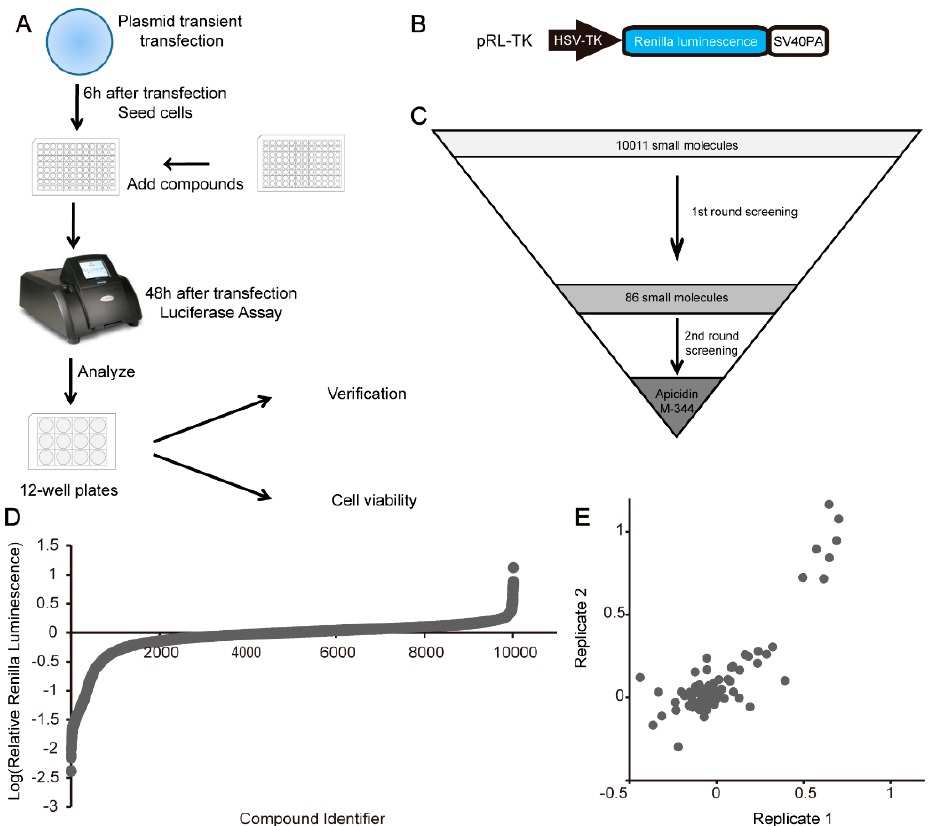
Figure 1. High-throughput screening for enhancing recombinant protein expression. ( A , C ) Schematic of the high-throughput screening platform for enhancing recombinant protein expression. ( B ) Schematic of the pRL-TK vector. HSV-TK, HSV-TK promoter; Renilla luminescence, Renilla luminescence reporter gene; SV40PA, SV40 polyA. ( D ) A waterfall plot of 100,010 compounds screened for increasing expression levels of recombinant protein. ( E ) Scatter diagram of 86 compounds evaluated in the second round of